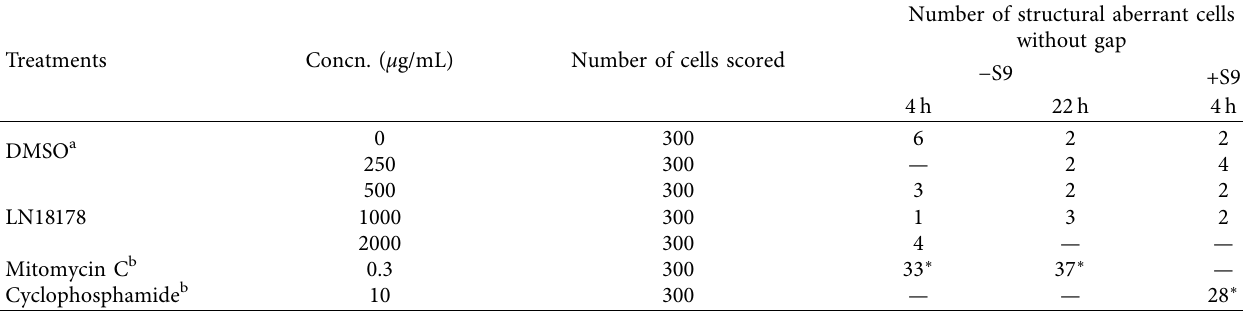
Table 10: Observations on chromosomal aberration induced by